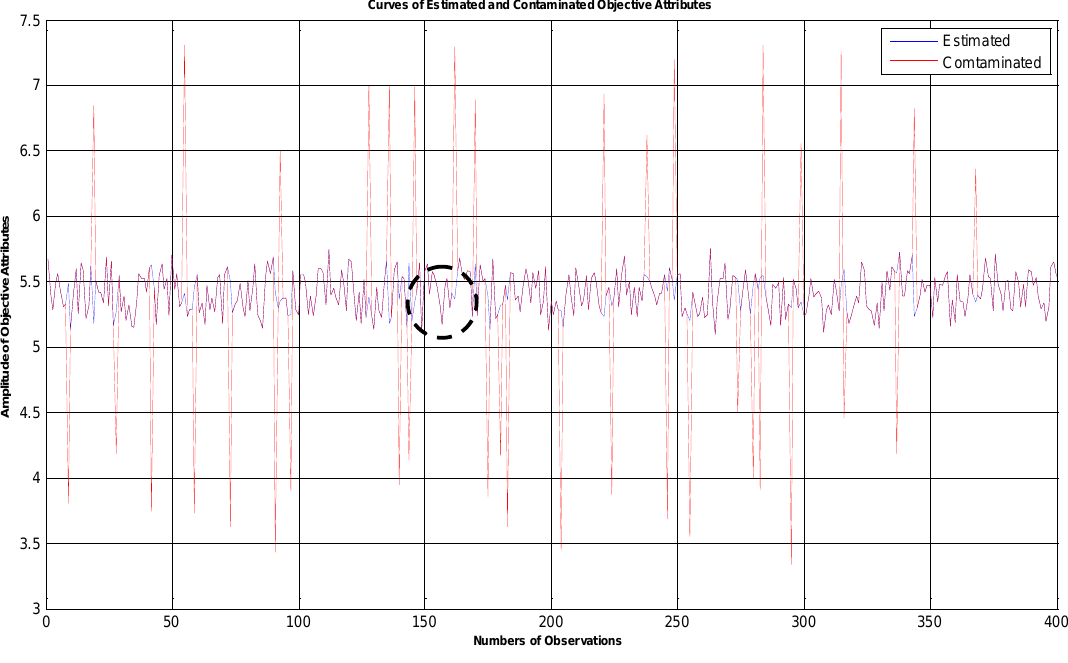
Figure 7. Shown the results for the contaminated objective attributes and the estimated objective attributes.